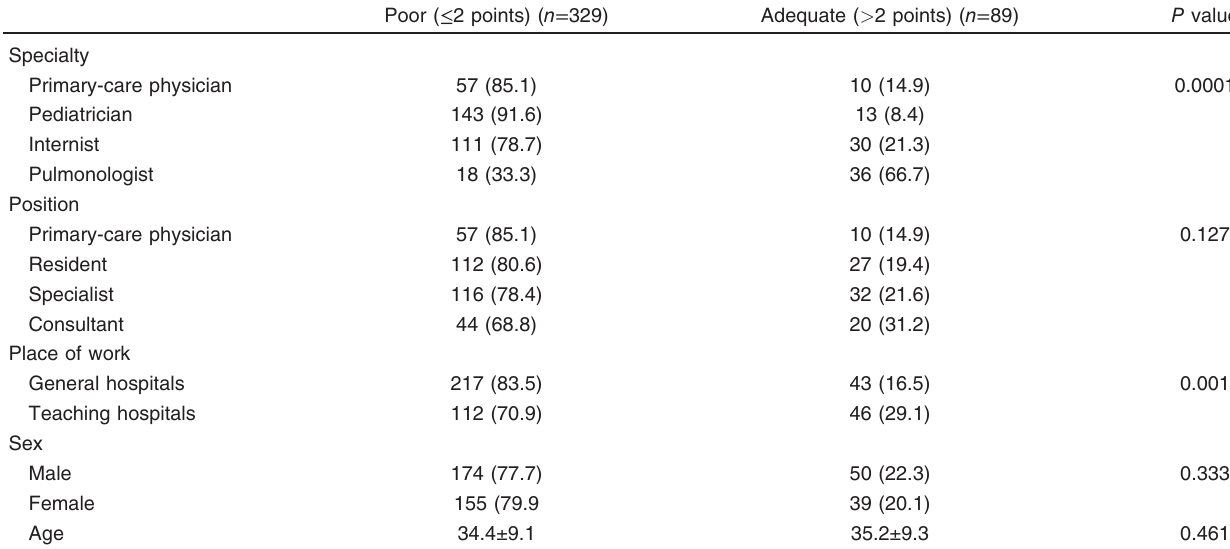
Table 2 Classification of physicians according to level of knowledge about inhalation